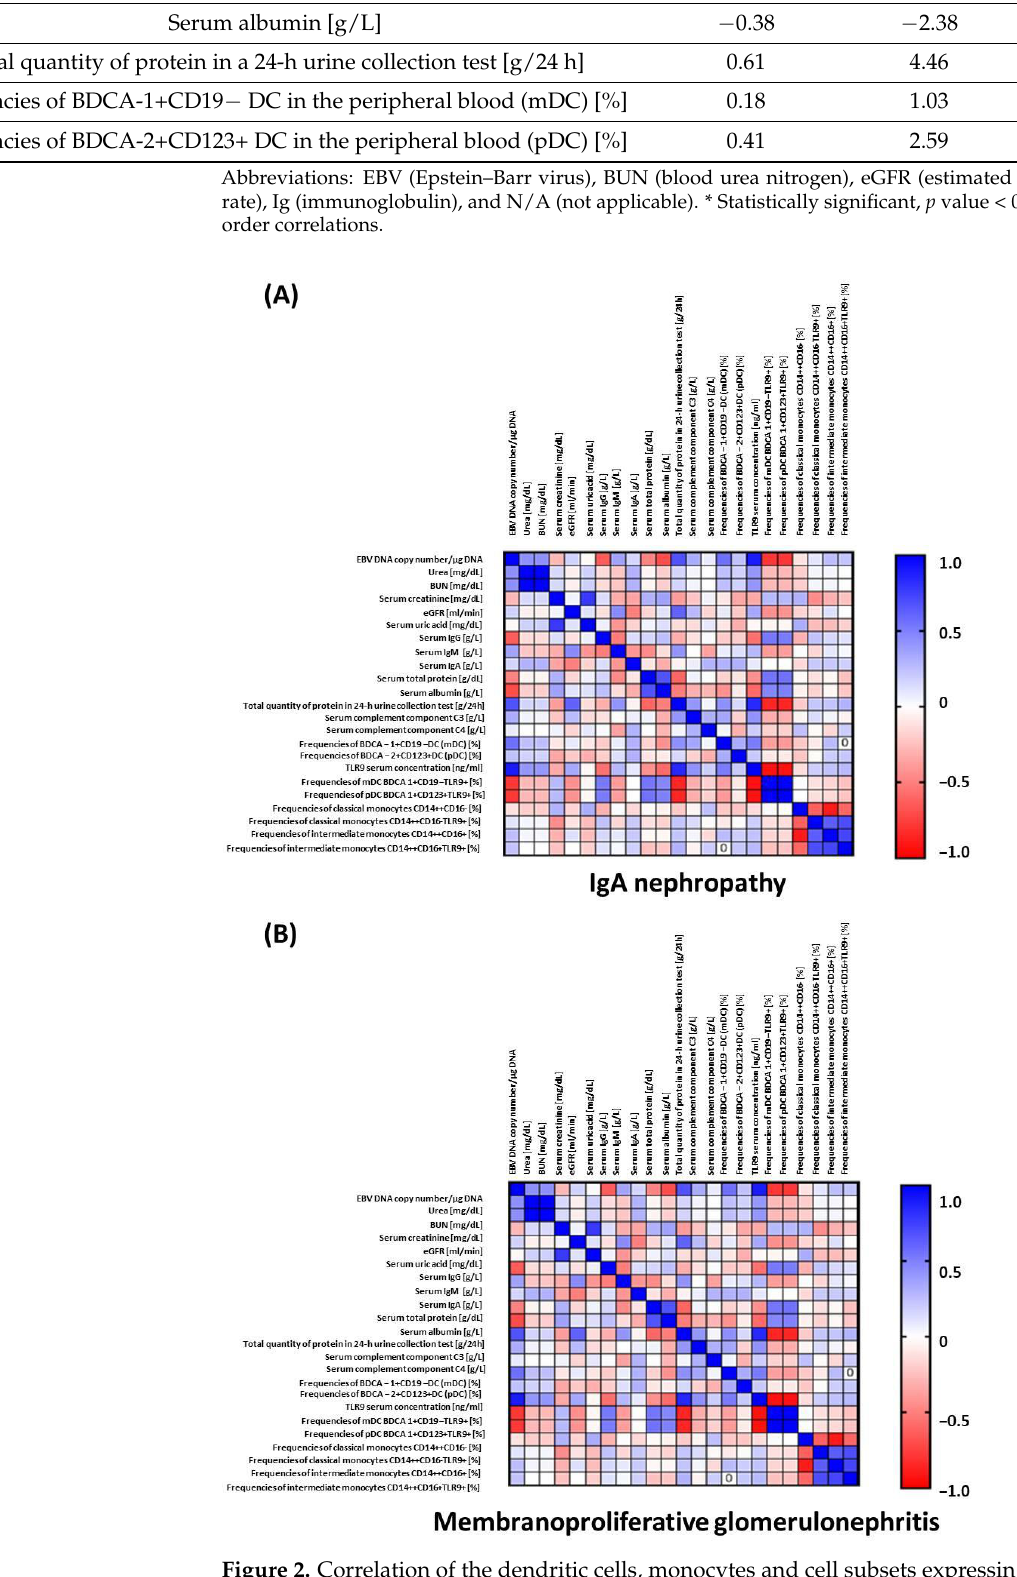
Figure 2. Correlation of the dendritic cells, monocytes and cell subsets expressing TLR9 antigen of IgAN ( A ) and MPGN ( B ) patients. Spearman ’s rank coefficients were presented as intensity of the colors. The closer Rs is to +1 or −1 , the stronger the correlation. A perfect positive correlation is +1 (blue color) and a perfect negative correlation is −1 (red color).